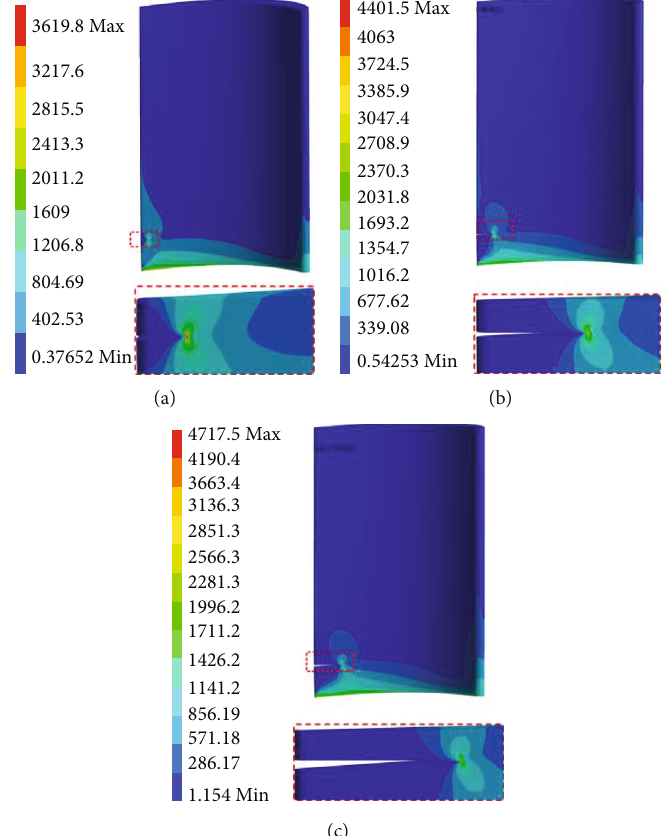
Figure 13: The stress distributions of blades with through-thickness cracks. (a) 2mm. (b) 5 mm. (c) 8